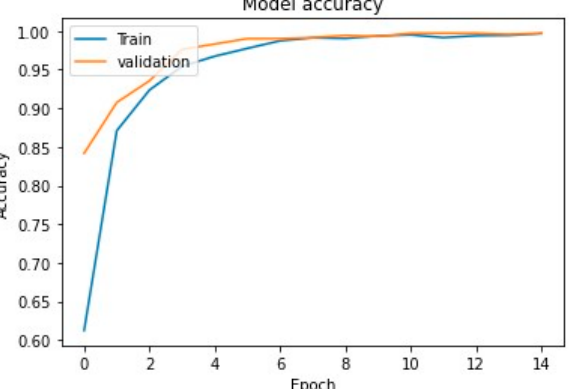
Figure 6. Model accuracy convergence of the model for training and validation .